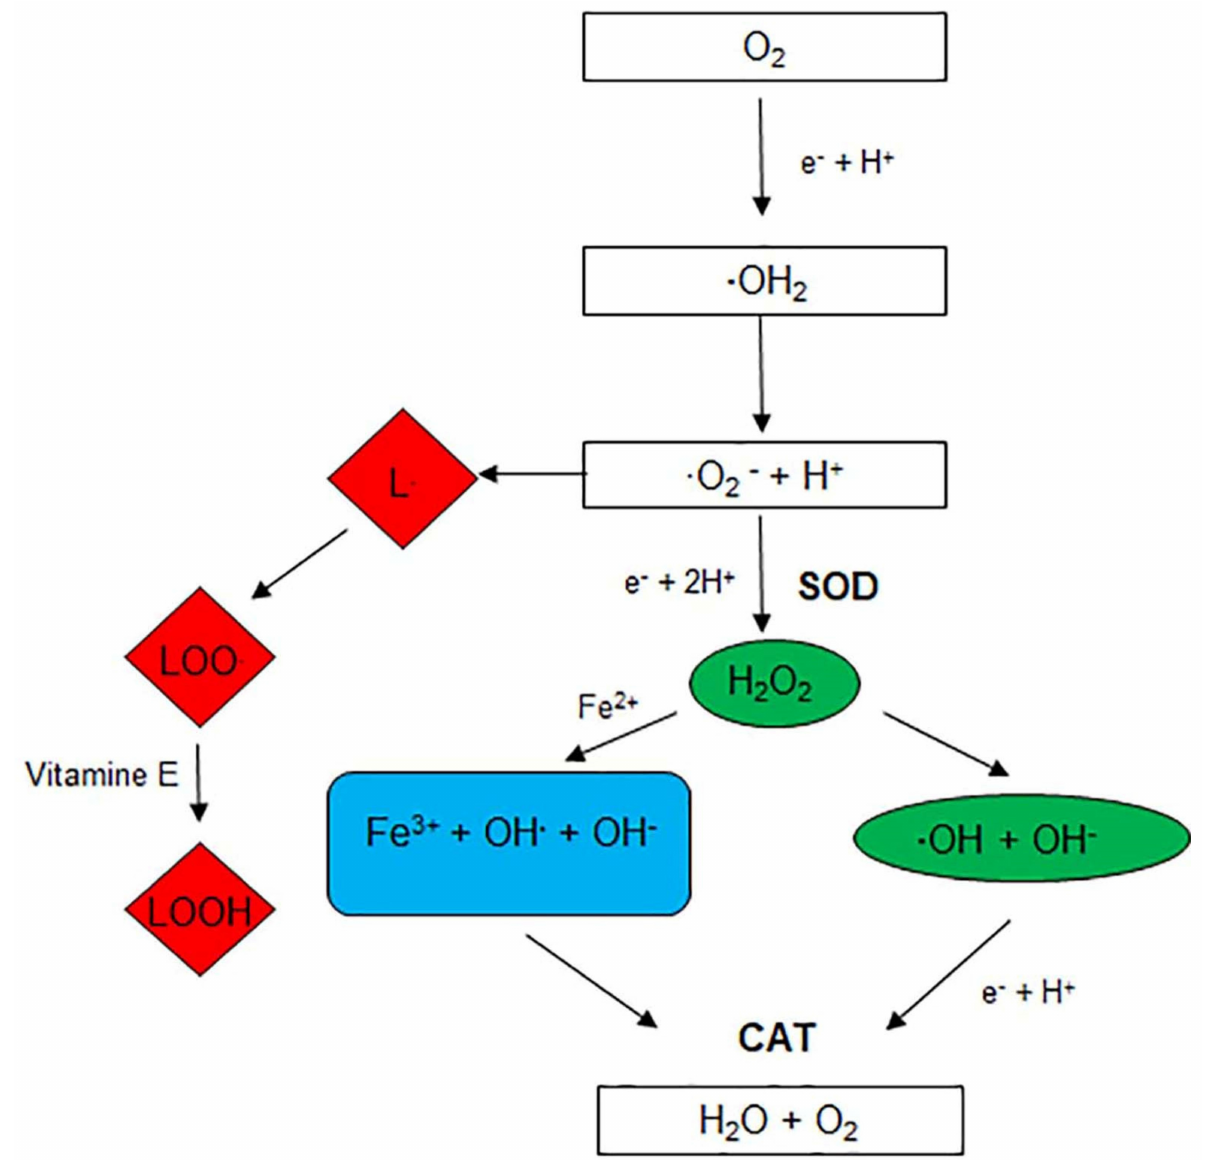
Figure 2. Schematic representation of the main reactions in which antioxidants are involved. Lipid peroxidation (red); Haber-Weiss reaction (green); Fenton reaction (light blue); SOD: superoxide dismutase; CAT: